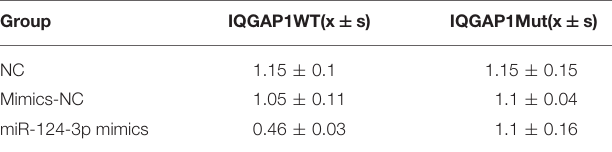
TABLE 5 | The dual-luciferase reporter gene detects the binding of miR-124 and IQGAP1.